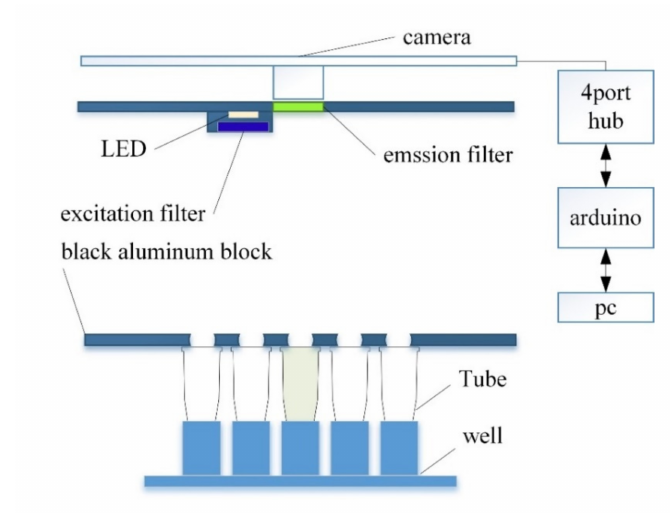
Figure 1. System structure